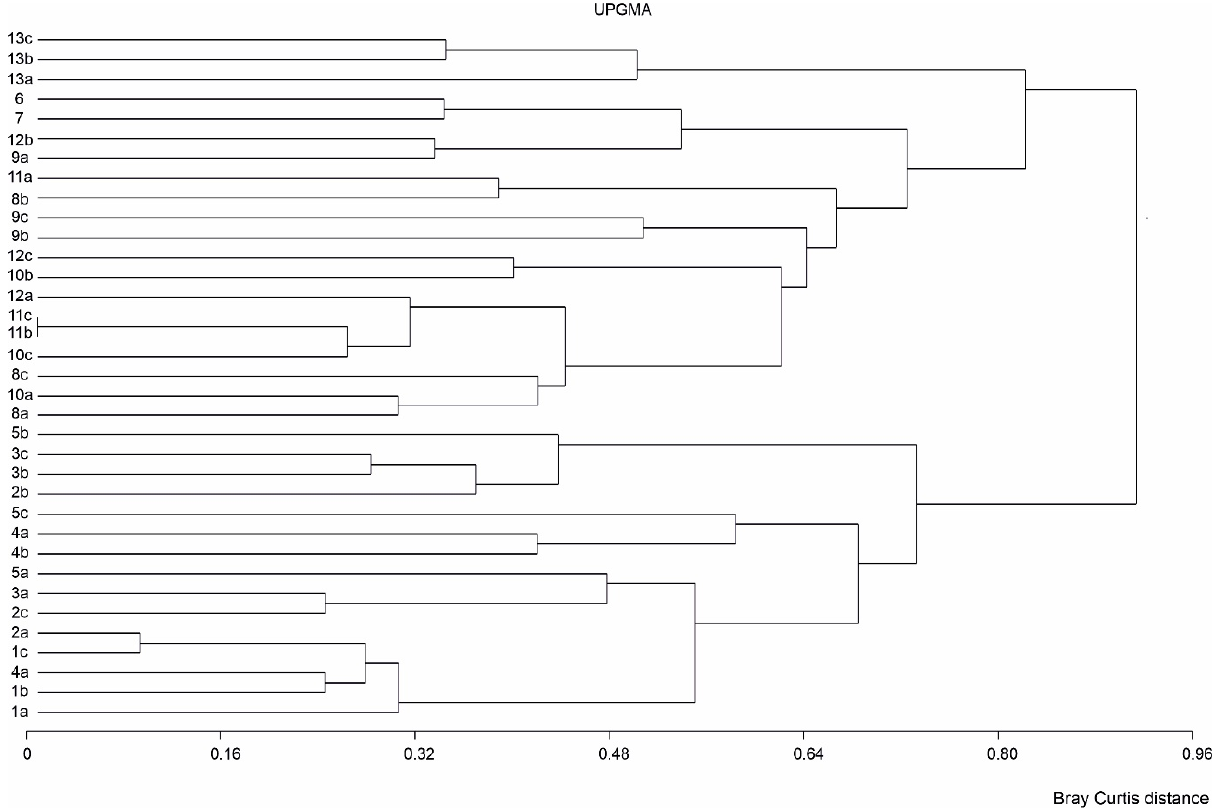
Figure 2. Similarities in benthos communities in water bodies from different habitat protections; the “Kocia Góra” Natural Landscape Complex and the “Stawy Pluderskie” Ecological Site (no.1 to no.5), the “Szopienice-Borki” Natural Landscape Complex (no. 6 and 7), the “Paprocany” Ecological Site (no. 8–12), the “Pogoria II” Ecological Site (no. 13); a–spring, b–summer, c–autumn. The number of taxa (H = 8.782850, p < 0.05) and the density of aquatic invertebrates (H = 7.923329, p < 0.05) were significantly different between the ponds located in the Sile- sian Upland and those in the Oświęcim Basin, with a mean density of benthic fauna of 2000 individuals/m 2 and 805 individuals/m 2 , respectively (Figure 3A). The average num- ber of taxa was 20 in the Silesian Upland and 12 in the Oświęcim Basin (Figure 3B). Sig-